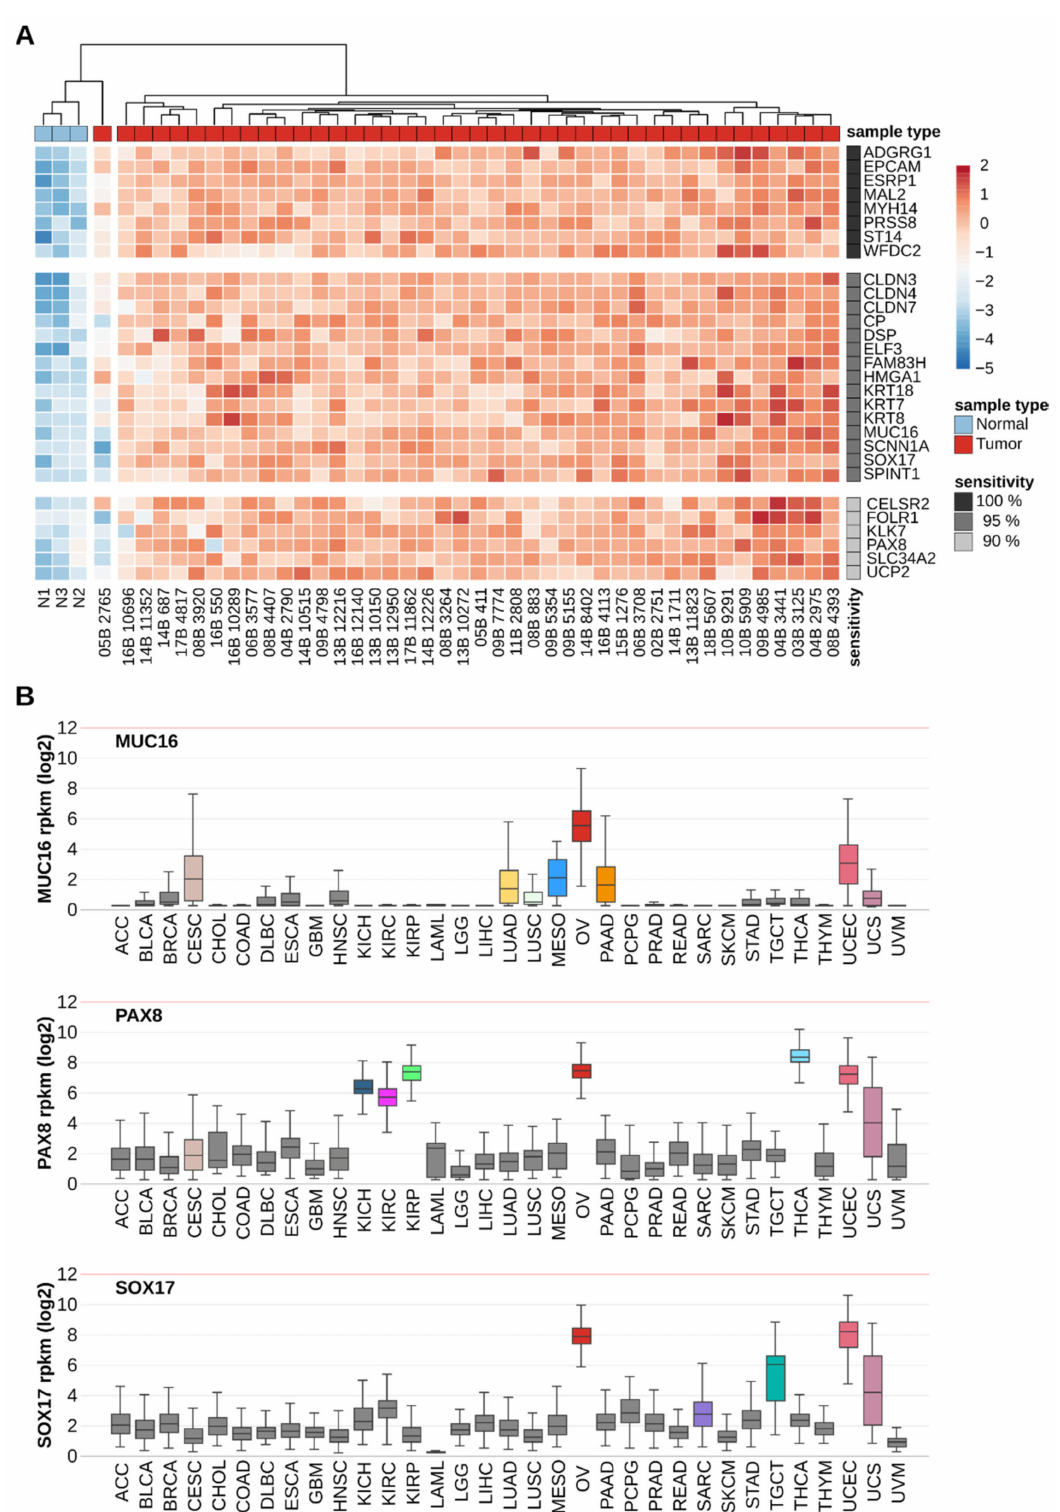
Figure 4. Discriminating power of single OSCA biomarker genes. ( A ) HeatMap of gene expression levels derived from the NanoString nCounter analysis for 29 genes showing 100% specificity and high sensitivity (100%, 95%, 90%) across 42 OSCA samples (tumor) and 3 healthy ovarian samples (normal). ( B ) Box plots of the gene expression distributions across 11,003 samples from 33 TCGA tumor